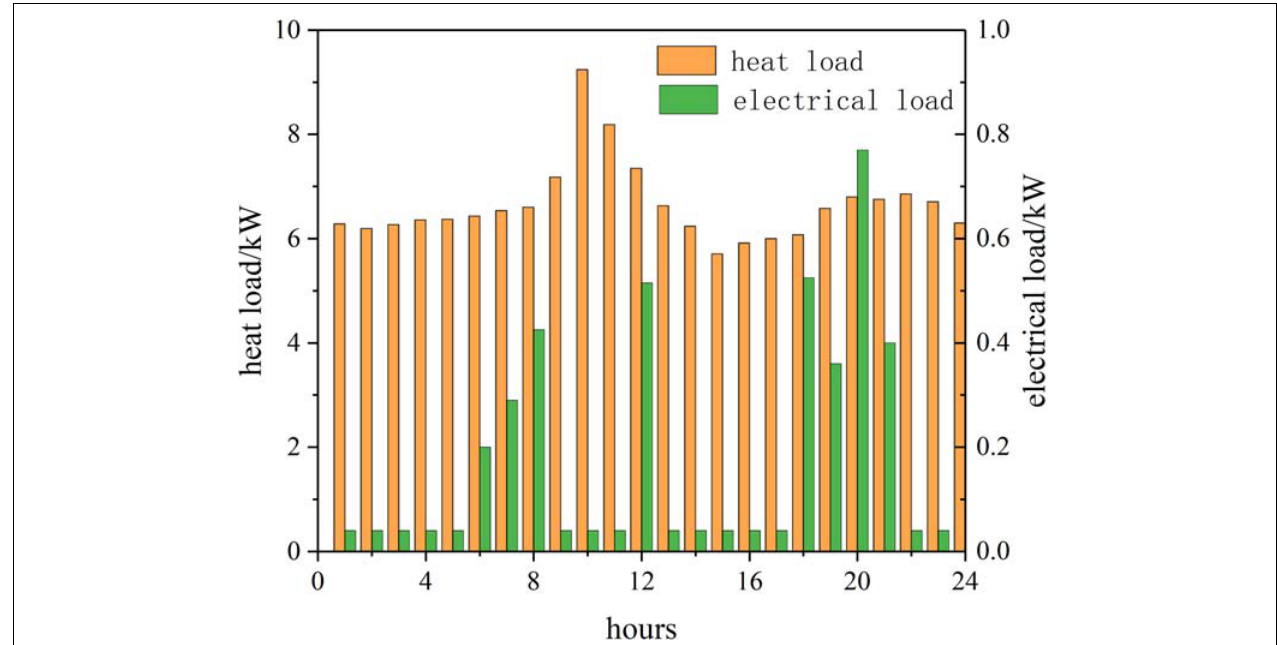
FIGURE 2 | Typical daily heat load and electric load in winter.